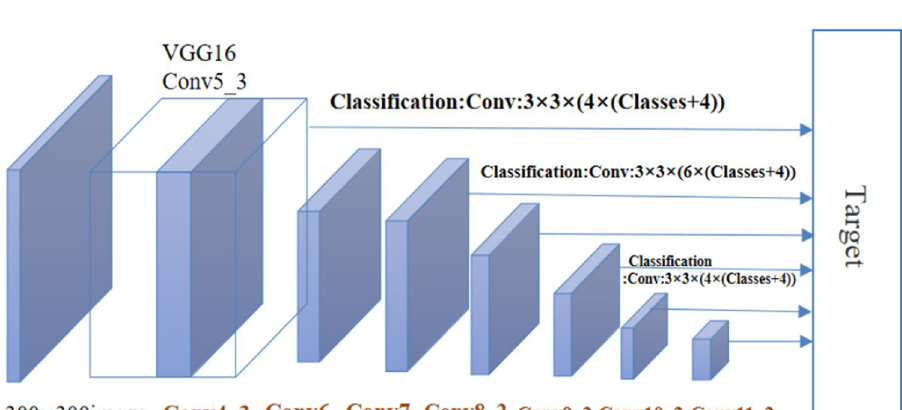
Figure 5. Using vgg-16 as the basic network, its extraction layer in the second half is also predicted, and detection is performed not only on other function diagrams, but also on the bottom convex 4–3 and 7 function points, so as to achieve compatibility with small